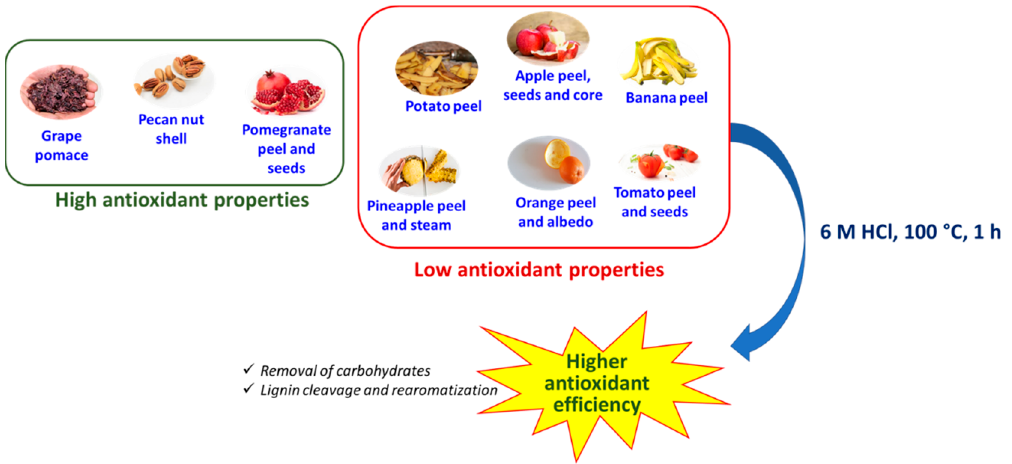
Figure 12. Overview of the antioxidant properties of agri-food byproducts and of the boosting effects of hydrolytic treatments.